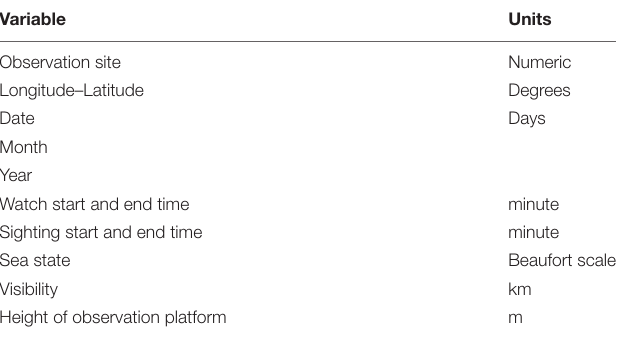
TABLE 2 | Spatio-temporal and other explanatory variables recorded during the watches.